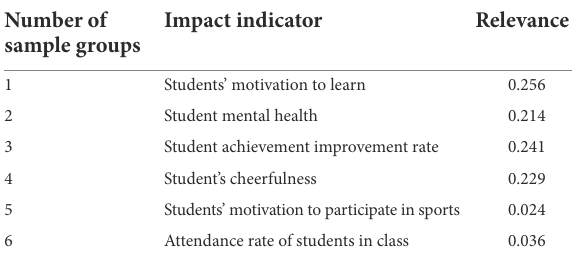
TABLE 2 Correlation analysis table of college student